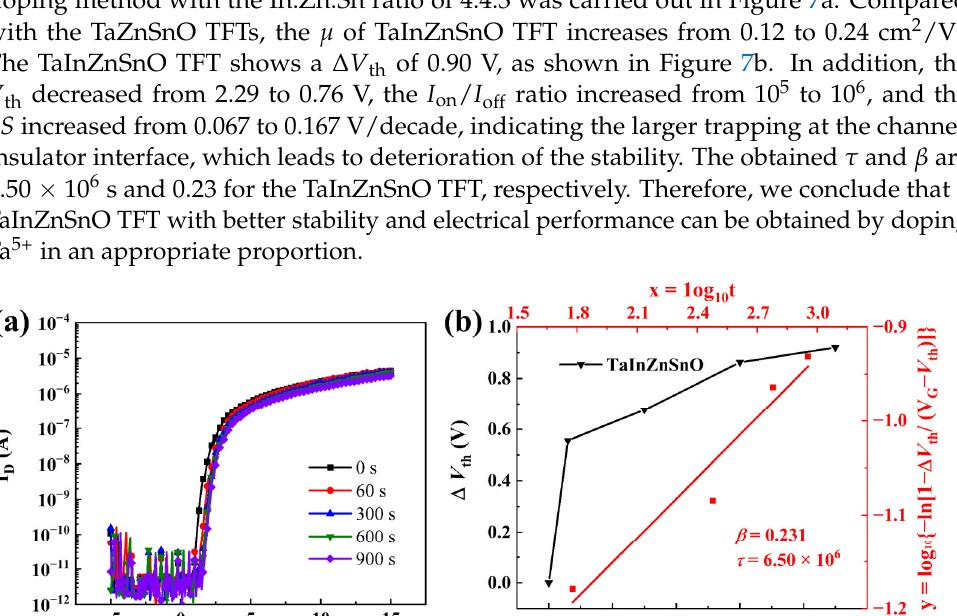
Figure 7. ( a ) PBS of TaInZnSnO TFTs. ( b ) The dependence of Δ V th on stress time and the fitted curves described by Equation (7) for the TaInZnSnO TFT.